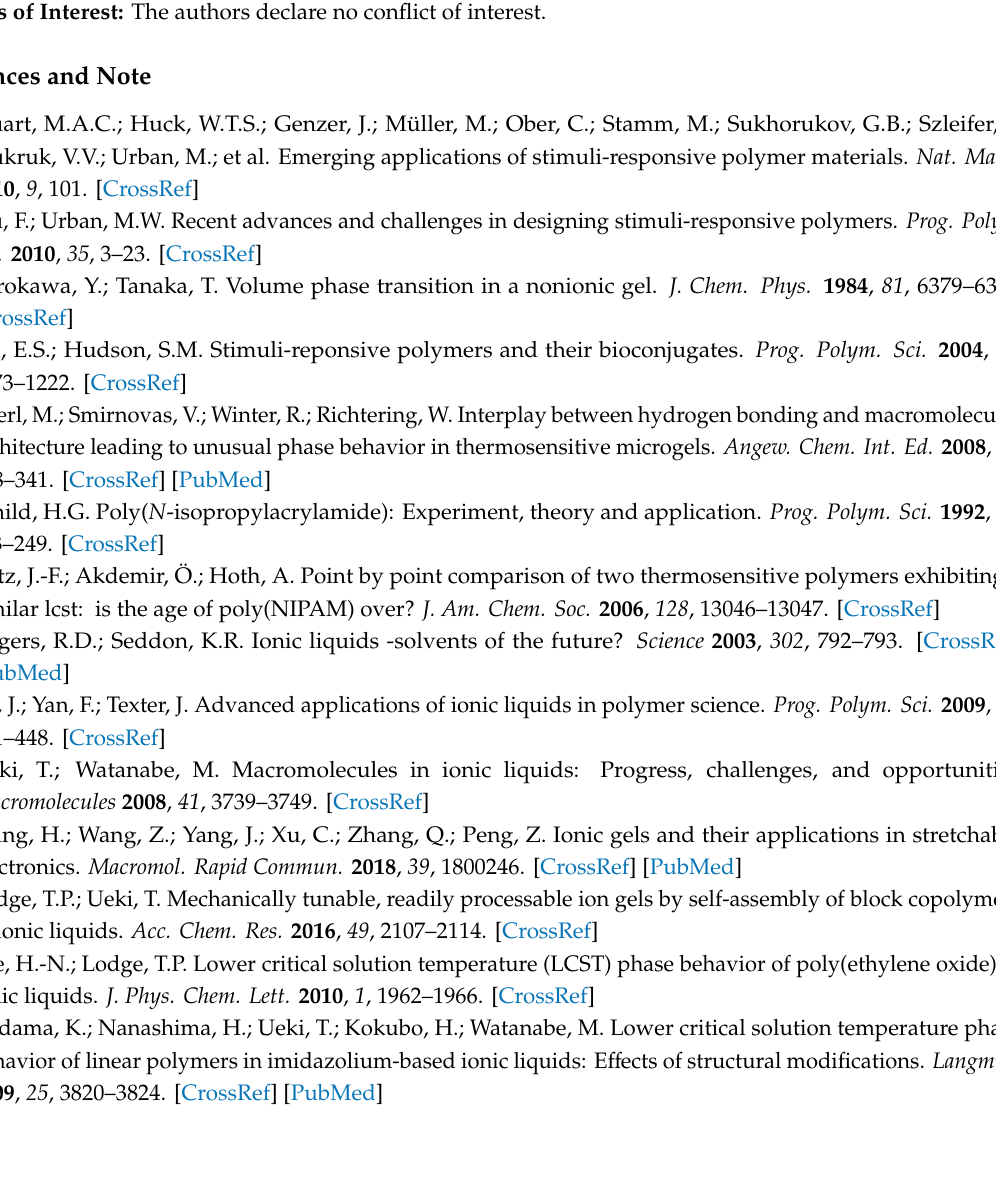
Figure S1: The storage (closed symbol) and loss (open symbol) moduli of m series with concentration of 5% and di ff erent tacticity, Figure S2: The storage (closed symbol) and loss (open symbol) moduli of Hm series with concentration of 5% and di ff erent tacticity, Figure S3: The loss factor as a function of temperature for m series with concentration of 5% and di ff erent tacticity, Figure S4: The loss factor as a function of temperature for Hm series with concentration of 5% and di ff erent tacticity. Symbols are the same as in Figure S3, Figure S5: The storage (closed symbol) and loss (open symbol) moduli of m79 solutions with di ff erent concentration, Figure S6: The storage (closed symbol) and loss (open symbol) moduli of Hm78 solutions with di ff erent concentration, Figure S7: The loss factor as a function of temperature for m79 solutions with di ff erent concentration. Symbols are the same as in Figure S3, Figure S8: The loss factor as a function of temperature for Hm78 solutions with di ff erent concentration. Symbols are the same as in Figure